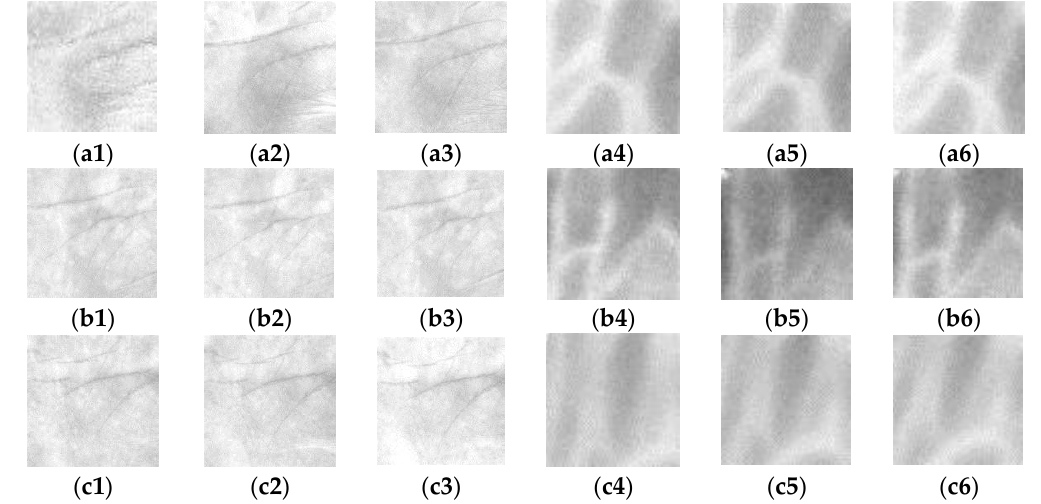
Figure 6. ( a1 )–( a3 ), ( b1 )–( b3 ) and ( c1 )–( c3 ) show the ROIs of palm regions cropped from Figure 2a1–